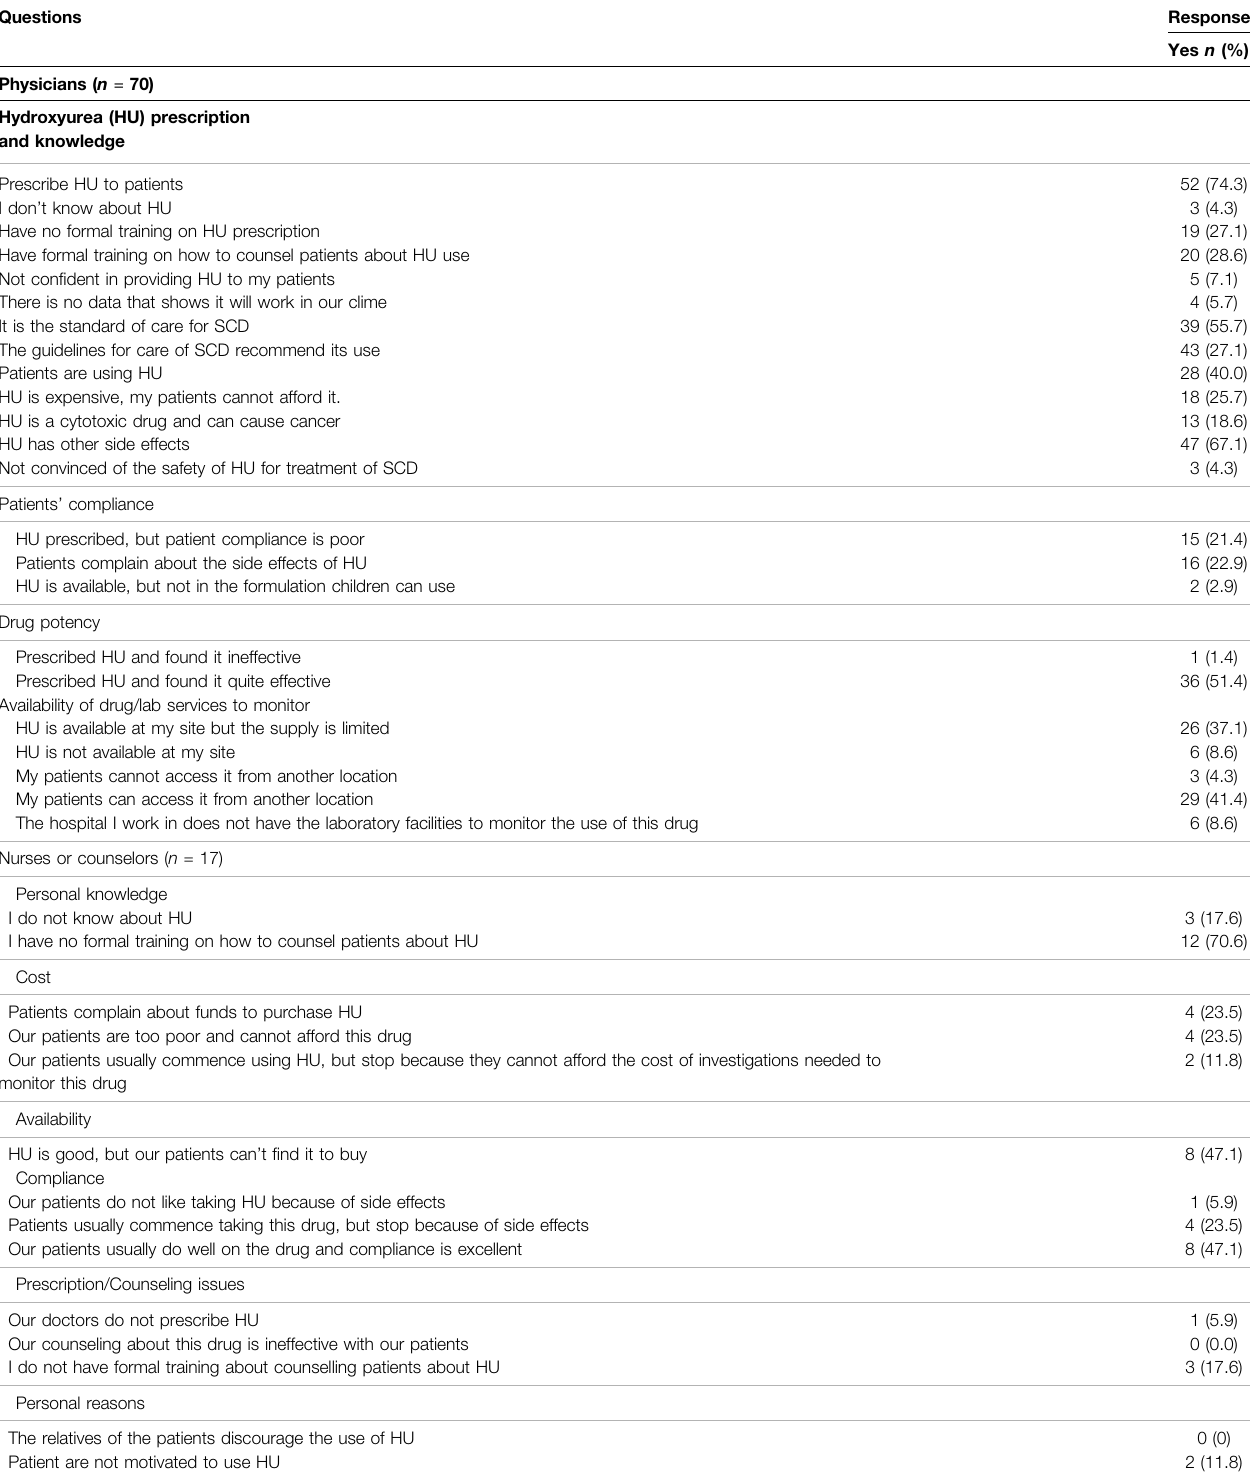
TABLE 2 | Clinician knowledge and practice regarding hydroxyurea at clinical facilities across Nigeria, 2019 ( N (cid:1)